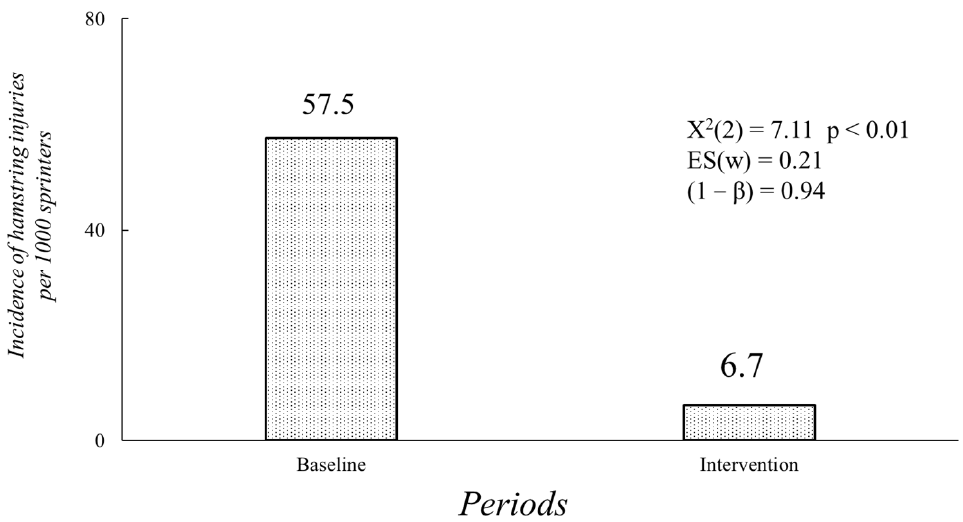
Figure 4. Effects of a combined prevention program on the incidence of hamstring injuries